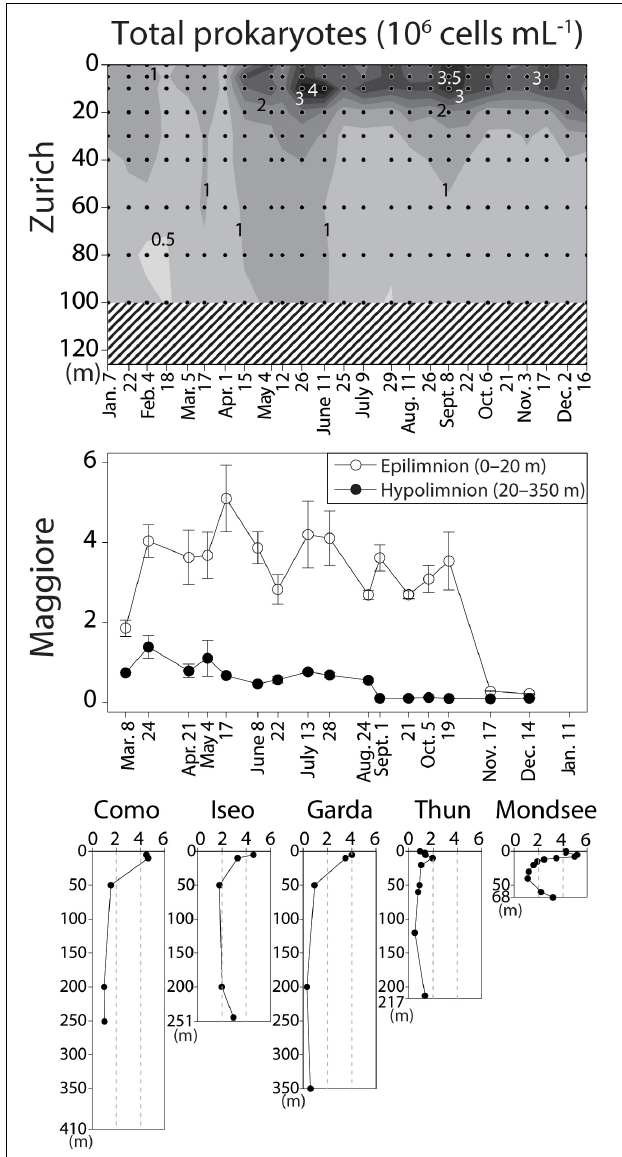
FIGURE 2 | Total prokaryotic abundance determined by enumeration of DAPI-stained cells (10 6 cells mL − 1 ). The vertical axes indicate water depth. For Lake Zurich, spatio-temporal measurement is shown by contours. Dots indicate sampling depths and dates, shaded areas missing measurements. The data for Lake Maggiore were measured in an integrated sample for epilimnetic (0–20 m) and hypolimnetic (20–350 m) water (see main text for detail). Error bars indicate standard